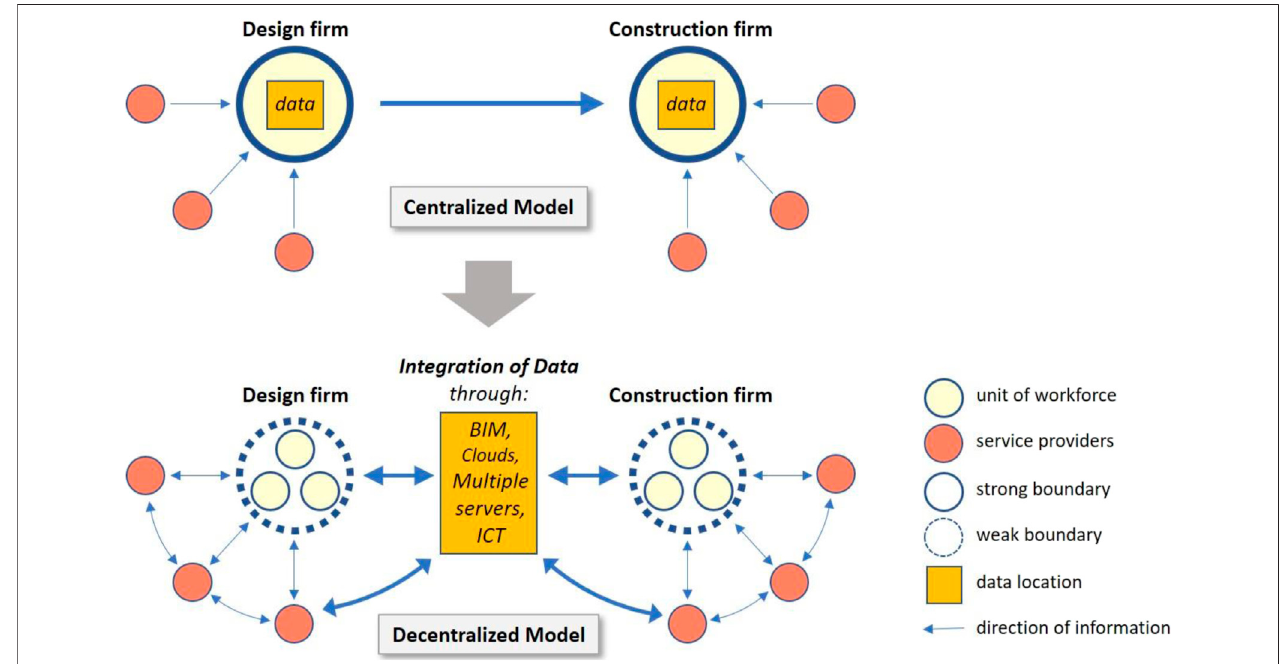
FIGURE 8 | Decentralization of workforce and integration of